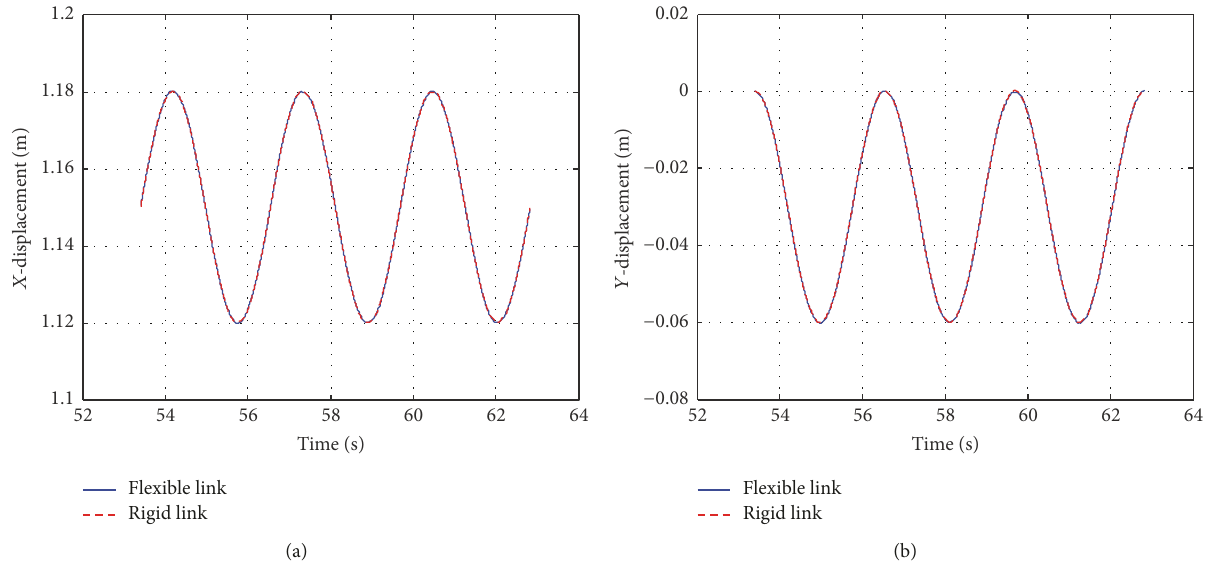
Figure 8: Displacement diagram of the moving platform: (a) displacement in 𝑋 direction; (b) displacement in 𝑌 direction.